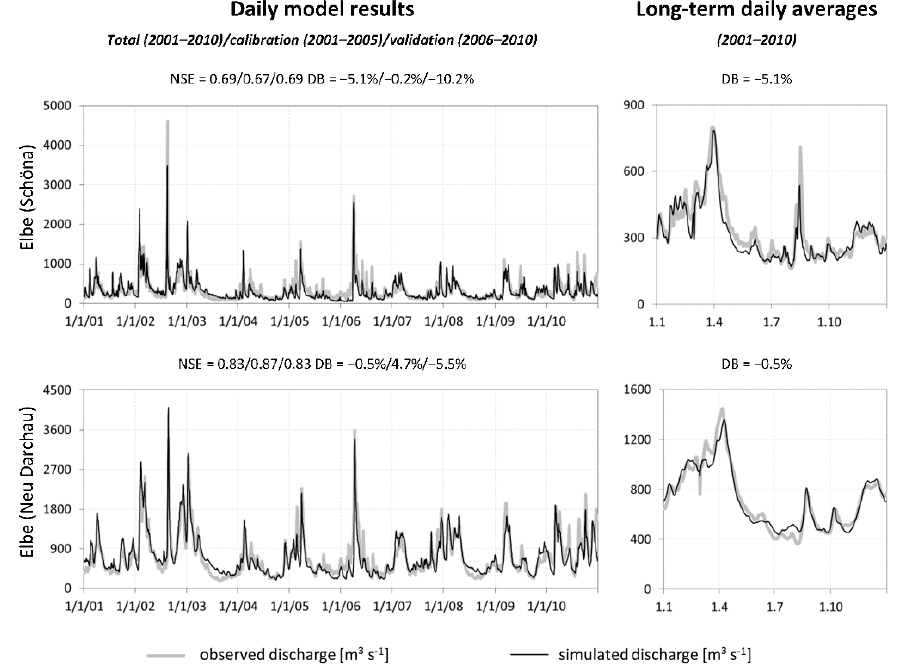
Figure 2. Calibration results for the Elbe river discharge at the most downstream gauge Neu Darchau and the intermediate Elbe gauge Schöna (Czech/German border) for the time period 2001–2010, separated into calibration and validation sub-periods. Table 6. Model performances for four discharge gauges of the Elbe river and six gauges of its main tributaries from the upstream to downstream location of tributaries.